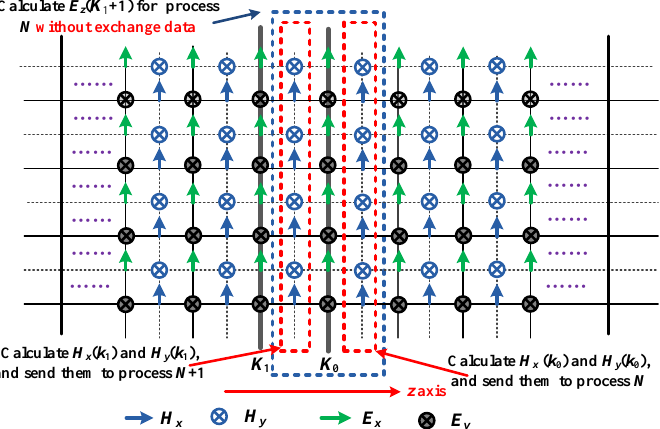
Figure 2. The data exchange scheme of the exterior surface for parallel FDTD scattering